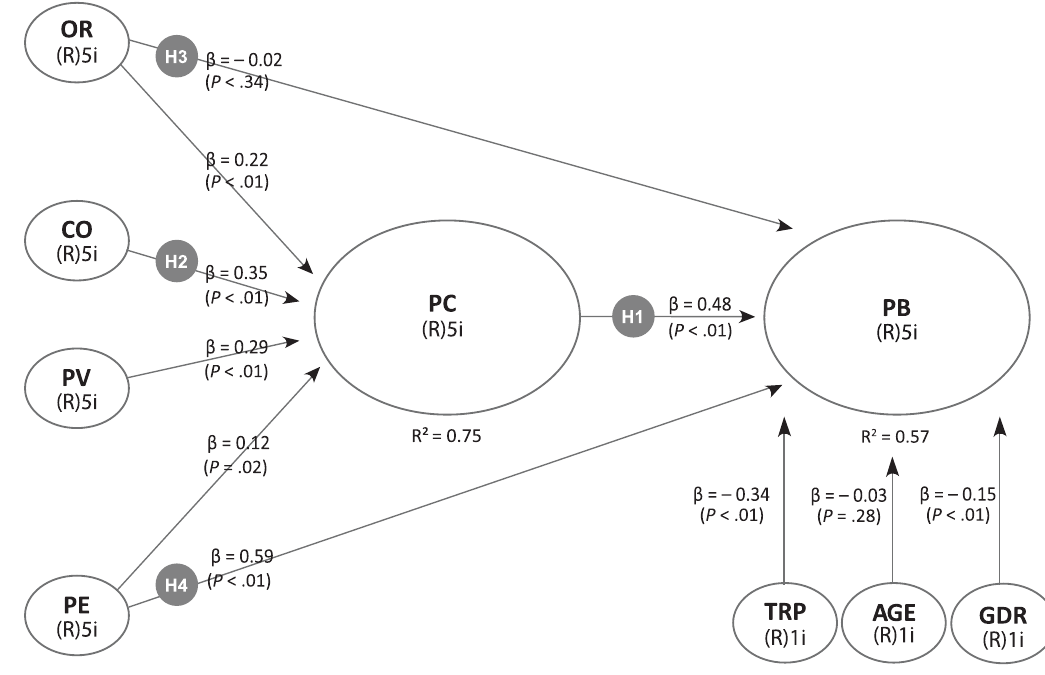
Figure 2. Structural model with the result